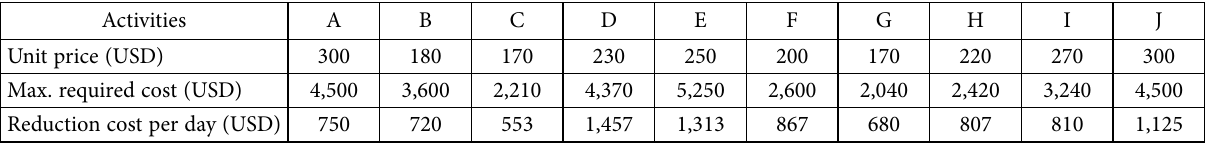
Table 5. The required cost for duration reduction